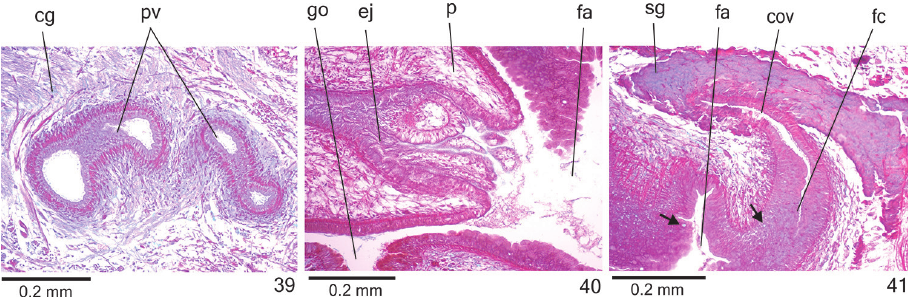
Figures 39–41. Cratera nigrimarginata sp. n., holotype, sagittal sections, 39 prostatic vesicle 40 penis papilla 41 female organs. Arrows indicate